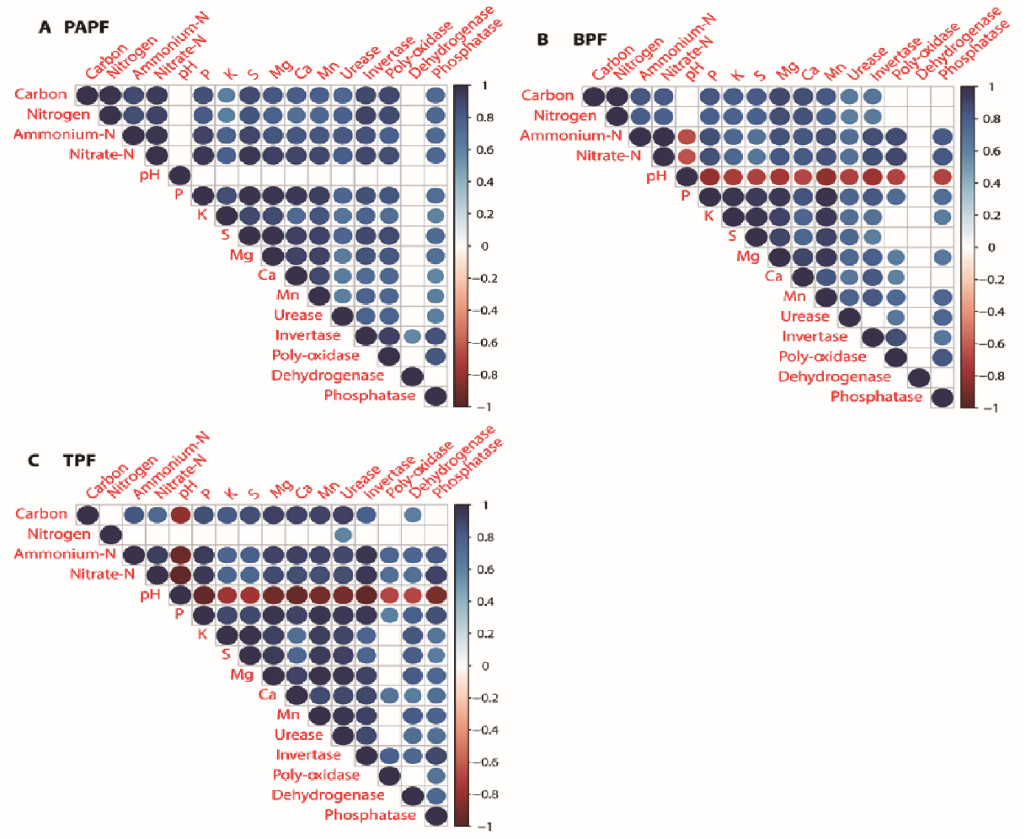
Figure 7. Pearson’s correlation of soil properties and enzymatic activities of dominant tree species ( A )PAPF, ( B ) BPF and ( C ) TPF in northeastern China. The significantly ( p < 0.05) positive (blue color) or negative (red color) correlations are indicated by colors and circle sizes, while the not significant correlations are omitted. Acronym’s definitions are as defined in Table 1.